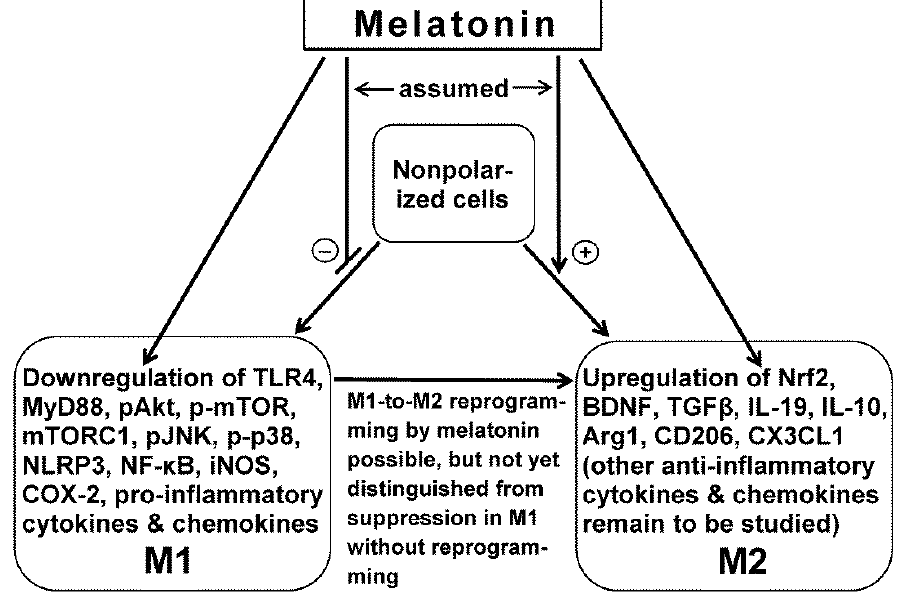
Figure 2. Main effects of melatonin in microglia, as indicated by the majority of studies (deviating findings have been reported for retinal microglia [57]). Melatonin favors polarization to M2, as shown by the upregulation of M2-specific markers, such as Arg1 and CD206, and disfavors M1, as indicated by the downregulation of iNOS. Indirect actions via other cell types are omitted but have been addressed in the current text. Of note: several of melatonin’s actions are mediated by SIRT1